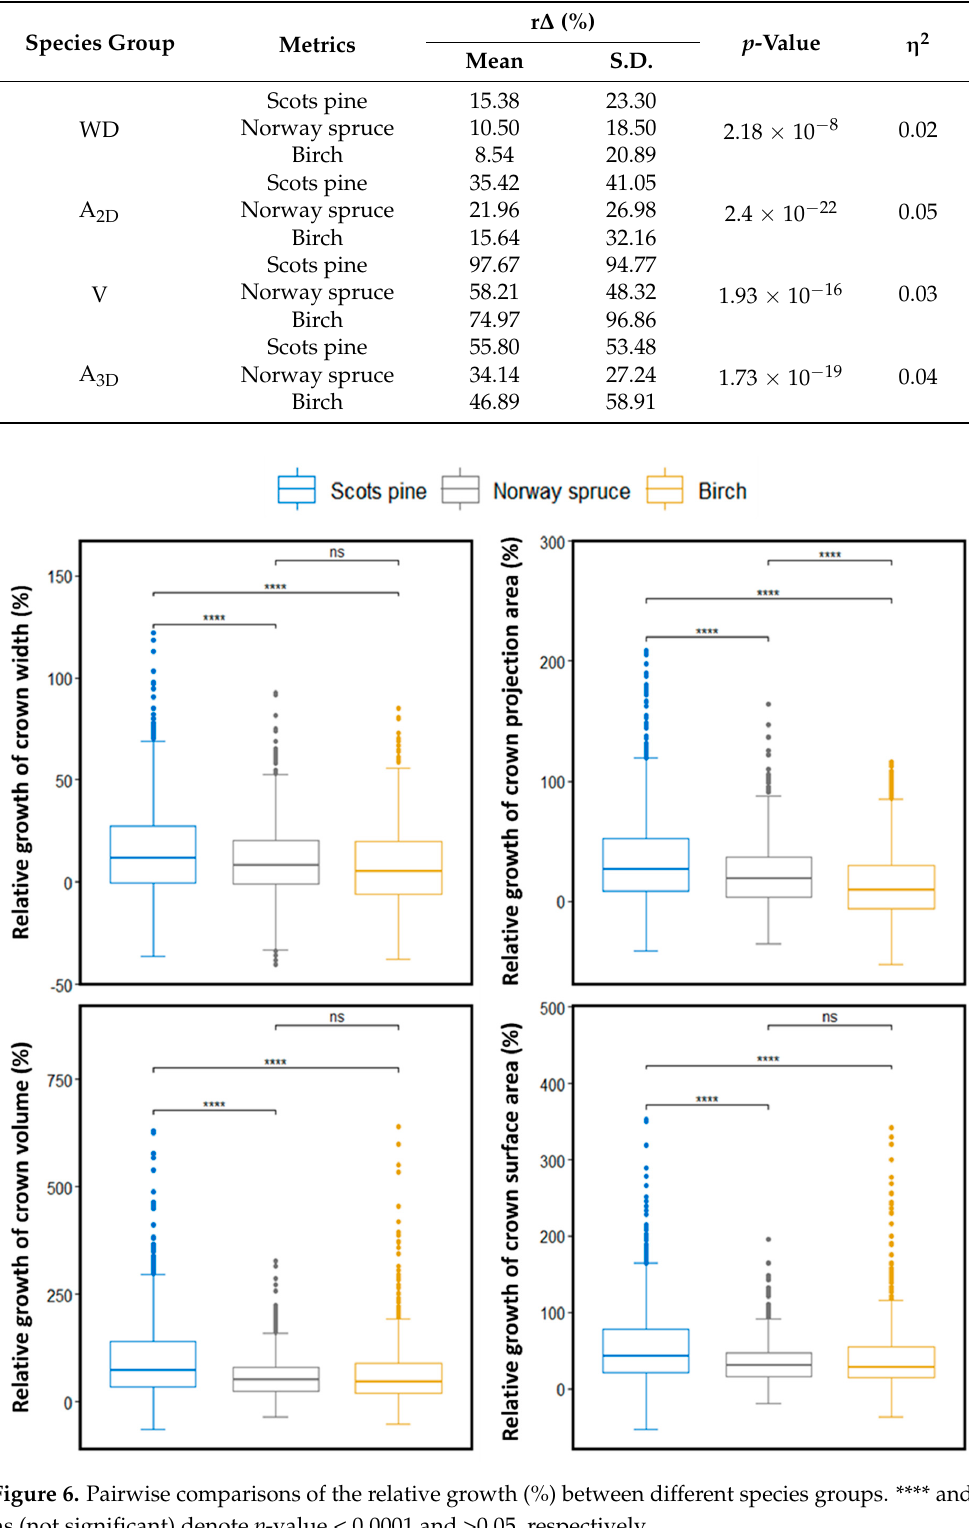
Table 5. Species-specific relative growth (r ∆ ) of ALS-derived crown metrics of width (WD), projection area (A 2D ), volume (V), and surface area (A 3D ) in T1 (2009) and T2 (2014). The Mean, standard deviation (S.D.), p -value, and generalized eta squared effect size ( η 2 ) values are reported.